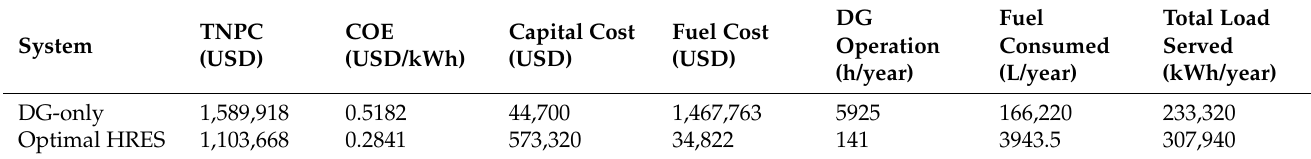
Table 11. Comparison of the DG-only and the optimal